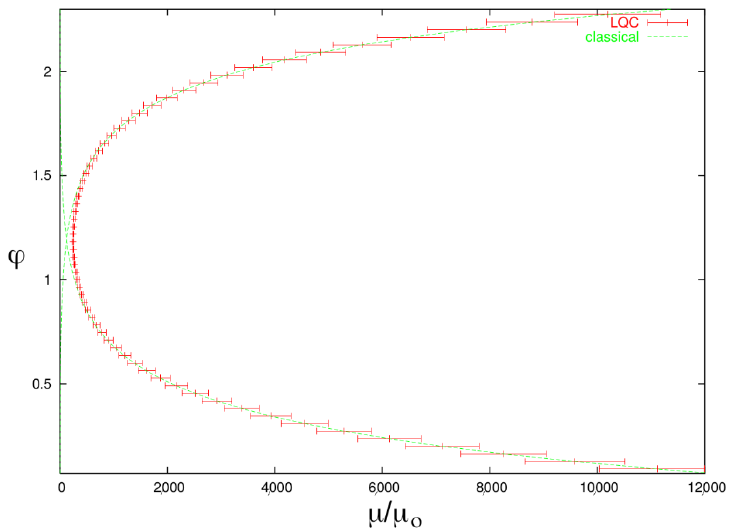
Figure 1. Expectation values and dispersion of | µ | (red horizontal bars) in terms of µ 0 as function of time ϕ for a coherent state, compared with classical trajectories (green dashed lines). Image from